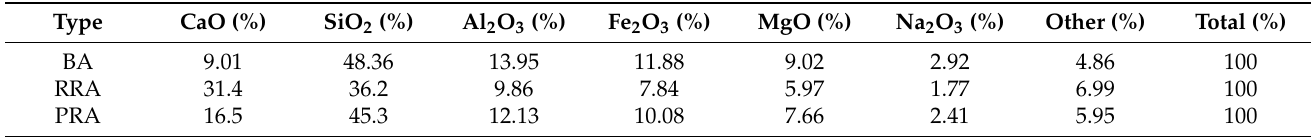
Figure 3. Grading of coarse aggregate. Table 7. Chemical composition of coarse aggregate.